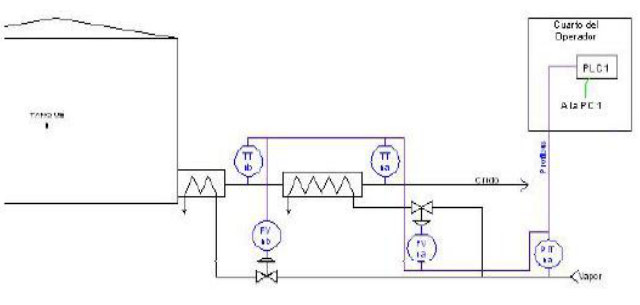
Figura 8: Configuración de los lazos de control y la red Profibus de los calentadores de cada tanque de crudo. Fuente: Los Autores, (2015).